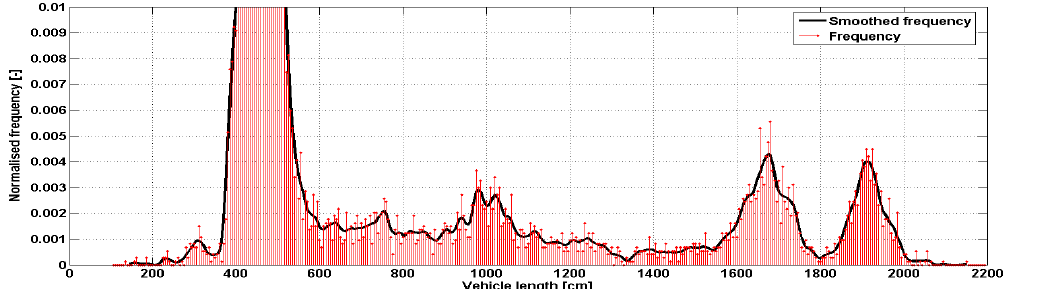
Figure 5. Normalised frequency of real vehicle lengths detected at a station on the Swiss National freeway network at a typical